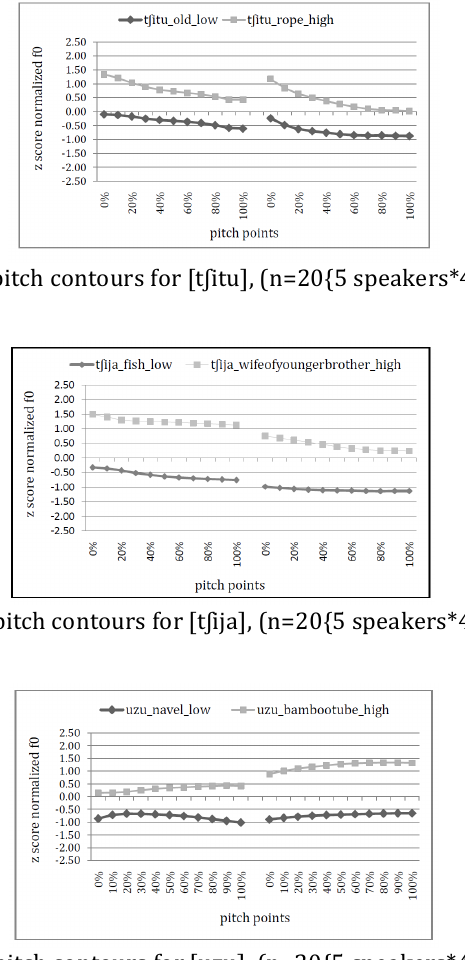
Figure 12: Normalized pitch contours for [uzu], (n=20{5 speakers*4 iterations